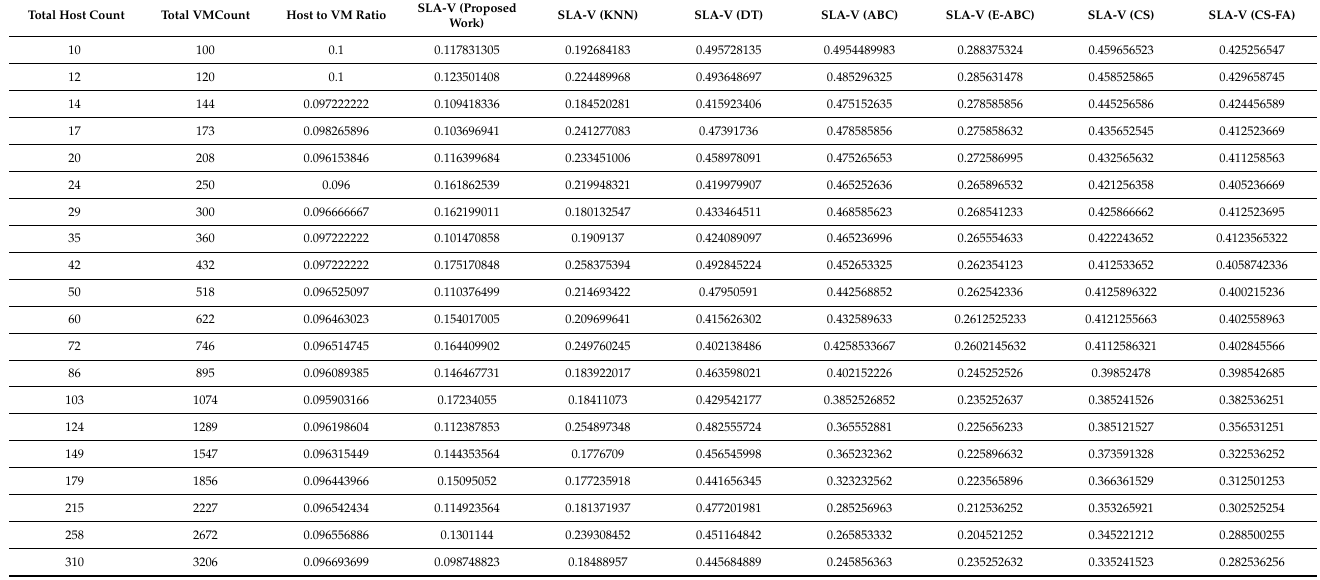
Table 3. Comparison in terms of SLA